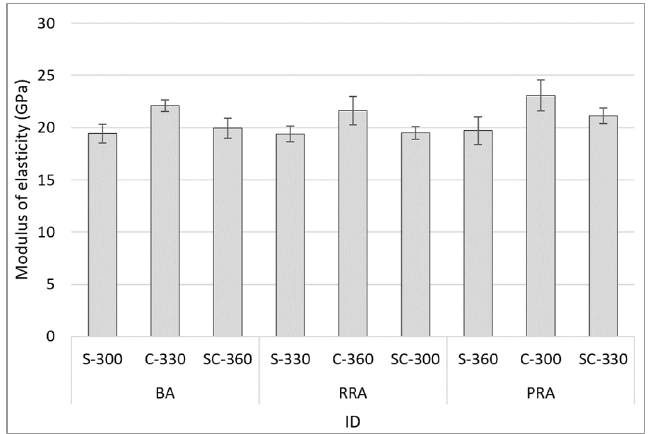
Figure 11. Modulus of elasticity of concrete.